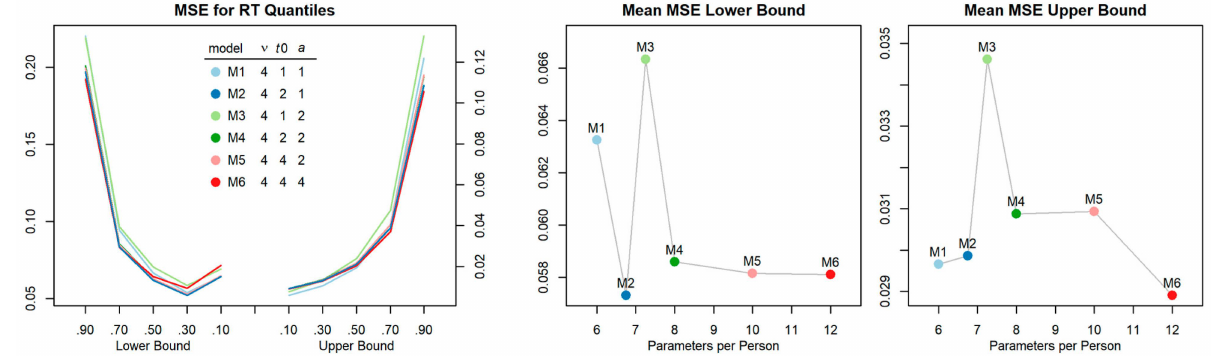
Figure A1. Mean squared error (MSE) for six alternative models fitted to the RT data of the switching task. The numbers in the legend correspond with the conditions the respective parameter was allowed to depend on, i.e., 1 = equal for all conditions, 2 = split by task-switch vs. repeat, and 4 = separate for all four conditions (task-switch × response–congruency).